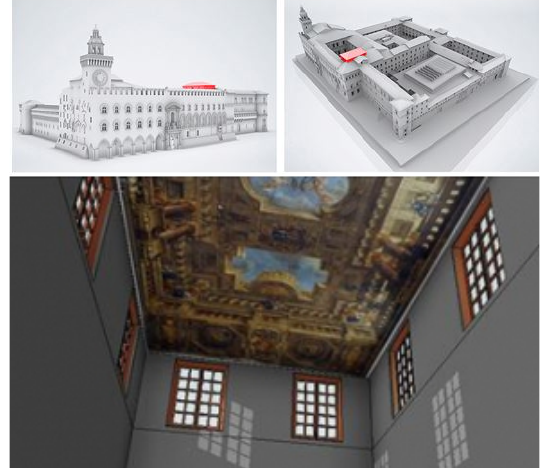
Figure 11. Advanced 3D -